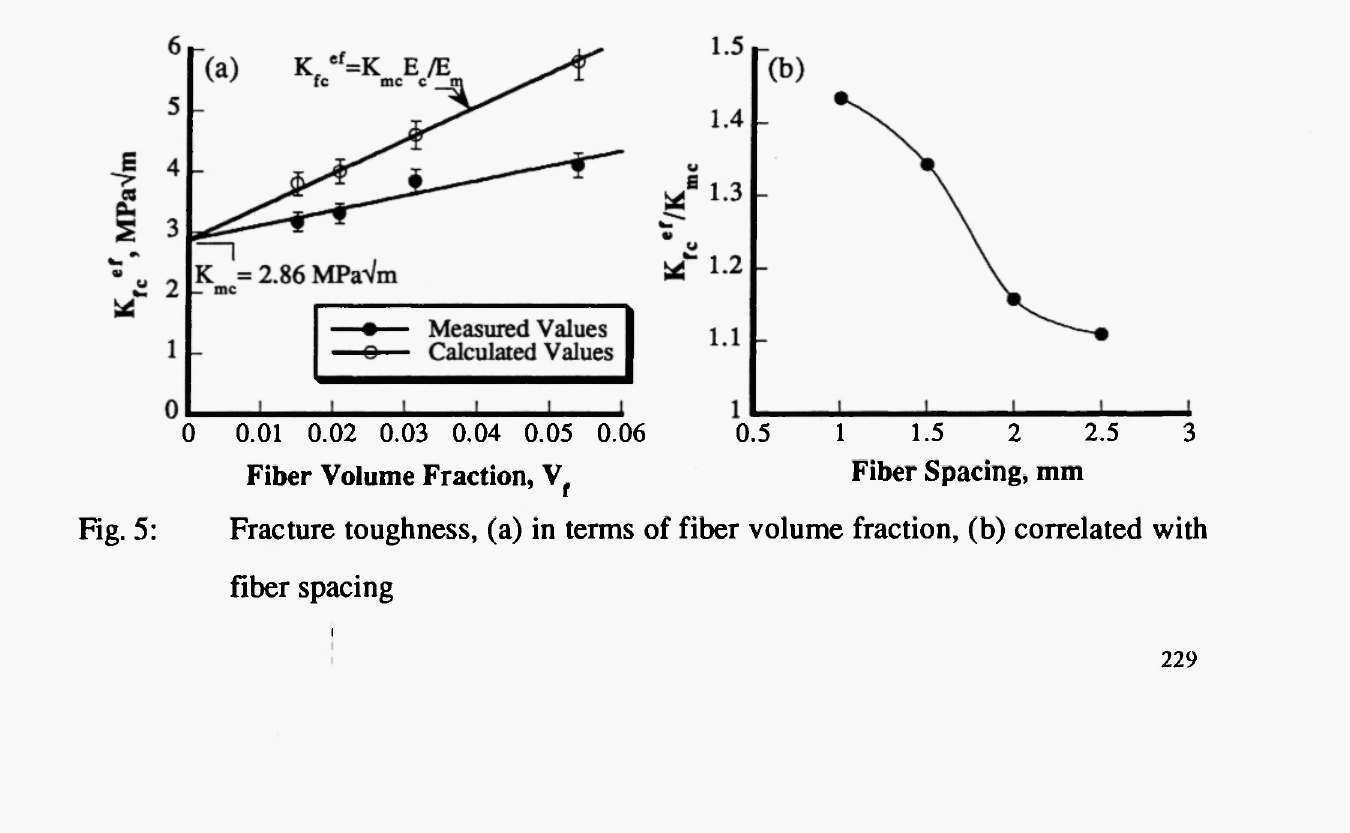
Fig. 5: Fracture toughness, (a) in terms of fiber volume fraction, (b) correlated with fiber